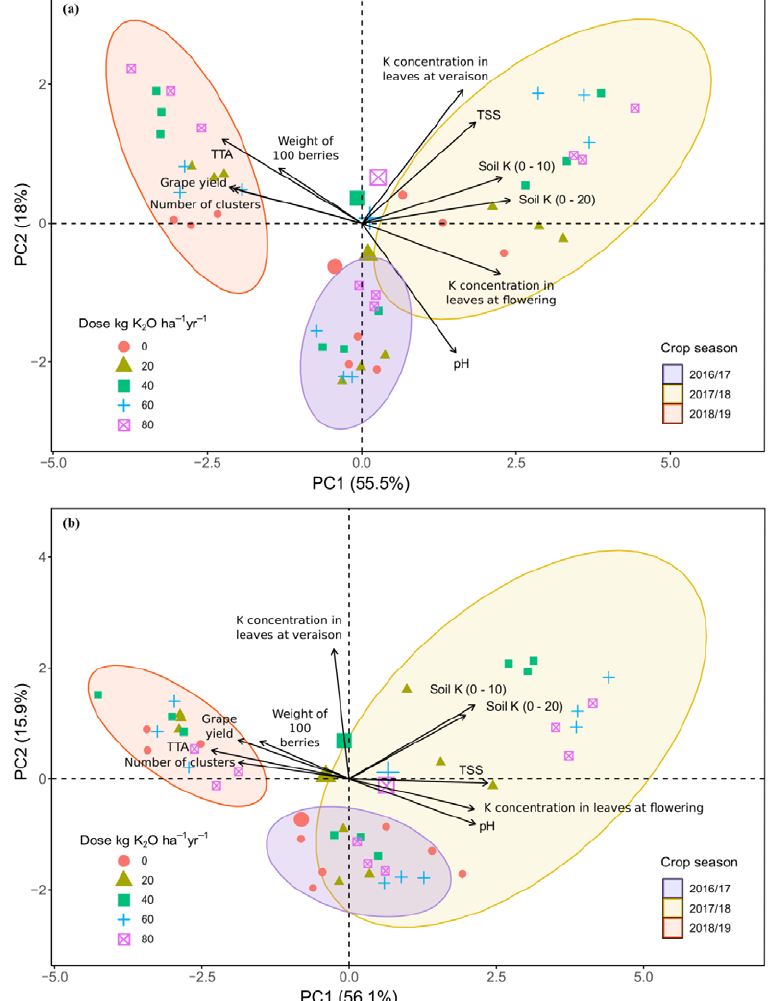
Figure 12. The relationship between principal component 1 (PC1) and principal component 2 (PC2) for variable groups of soil (0–10 and 0–20 cm) and leaf K concentration during flowering and veraison, vine yield (number of clusters per plant, grape yield per plant and weight of 100 berries) and must chemicals parameters (SST, pH and TTA) detected in 2016/17, 2017/18 and 2018/19, in ‘Chardonnay’ ( a ) and ‘Pinot Noir’ ( b ) soil fertilized with K.